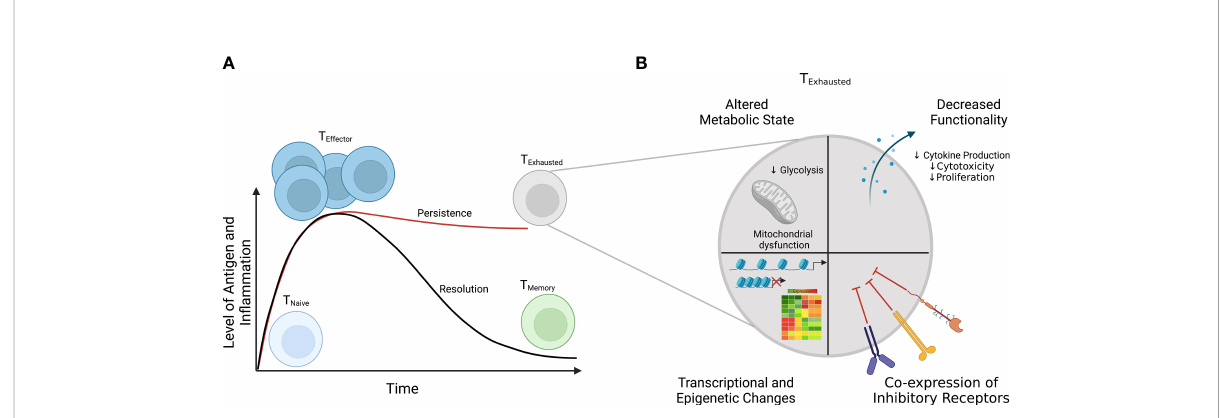
FIGURE 2 Differential T-cell responses to short-term (acute) and long-term (chronic) infections. (A) In acute infections (solid black line), T-cell response spikes are marked by acquisition of effector function (e.g., cytokine production) and upregulation of activation markers and clonal expansion. When an infection or antigen is cleared, a small subset of effector T cells differentiate into memory cells, poised to reactivate upon re-infection, while most cells die. However, if the antigen level or in fl ammation persists as in the case during chronic infections, T cells develop into a distinct subset, termed “ exhausted ” T cells (solid red line). (B) Among the characteristics that de fi ne exhausted T cells are 1) coordinate expression of multiple immunoregulatory receptors, 2) decreased effector function, 3) altered metabolic function, and 4) altered transcriptional and epigenetic